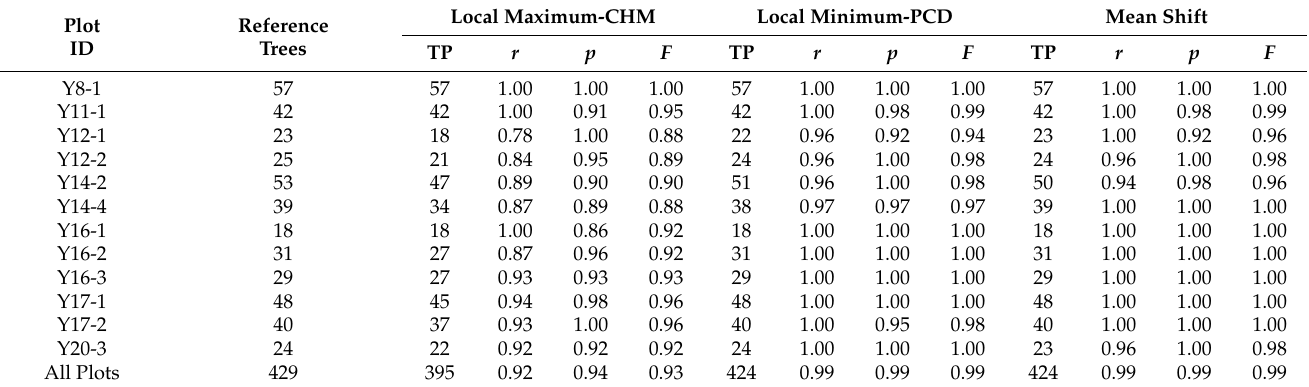
Table 4. Accuracy assessment for ITD in poplar plots of different ages under leaf-off conditions. Plot Reference ID